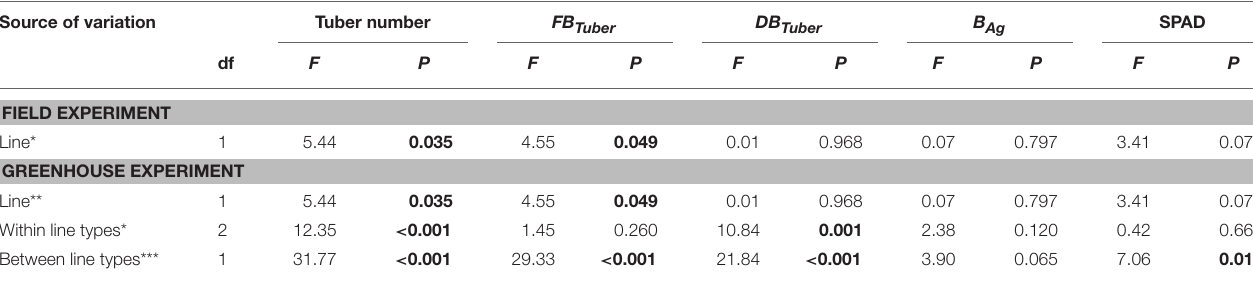
TABLE 5 | ANOVA for number of tubers and above-ground and tuber biomass in the greenhouse (2014) and field experiment (2015). Source of